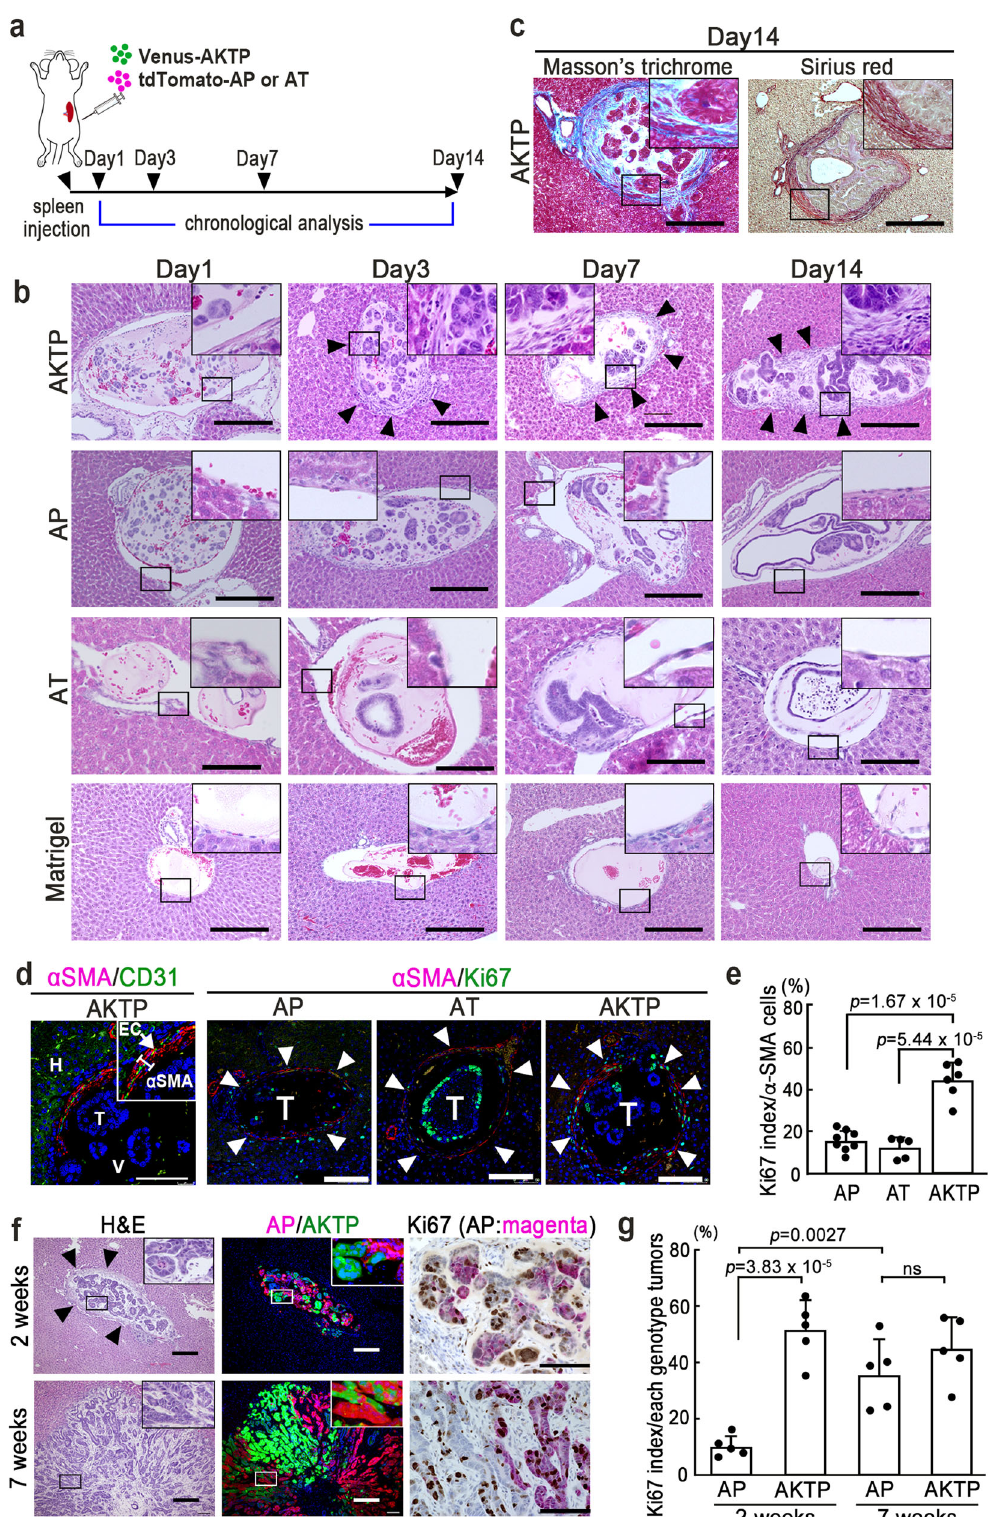
the depletion of AKTP cells (Fig. 3c). Compound mutant mice carrying Apc and Trp53 did not develop metastases of intestinal tumors 10 ; thus, AP tumors have been considered non-life- threatening. This point is particularly important to consider when devising a therapeutic strategy. Molecular-targeting drugs against activated KRAS can eliminate malignant cells that